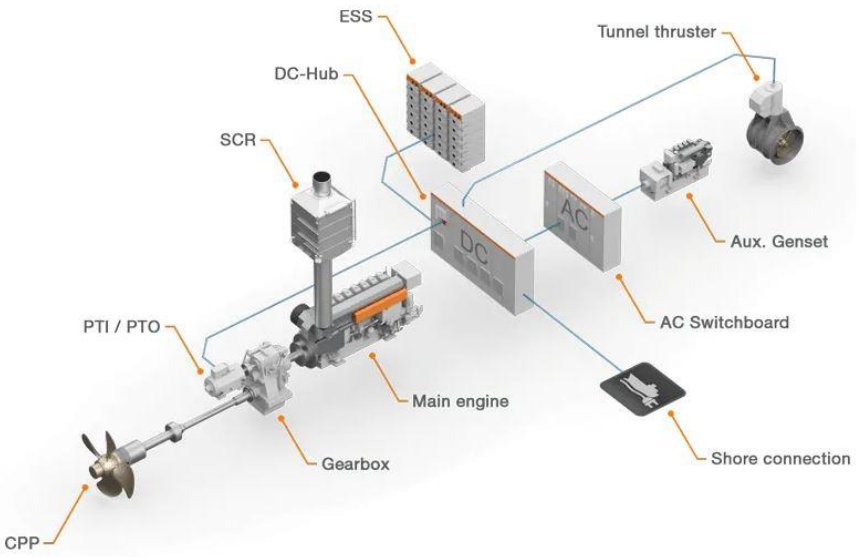
Figure 16. Hybridised CPP arrangement for short sea shipping [82].